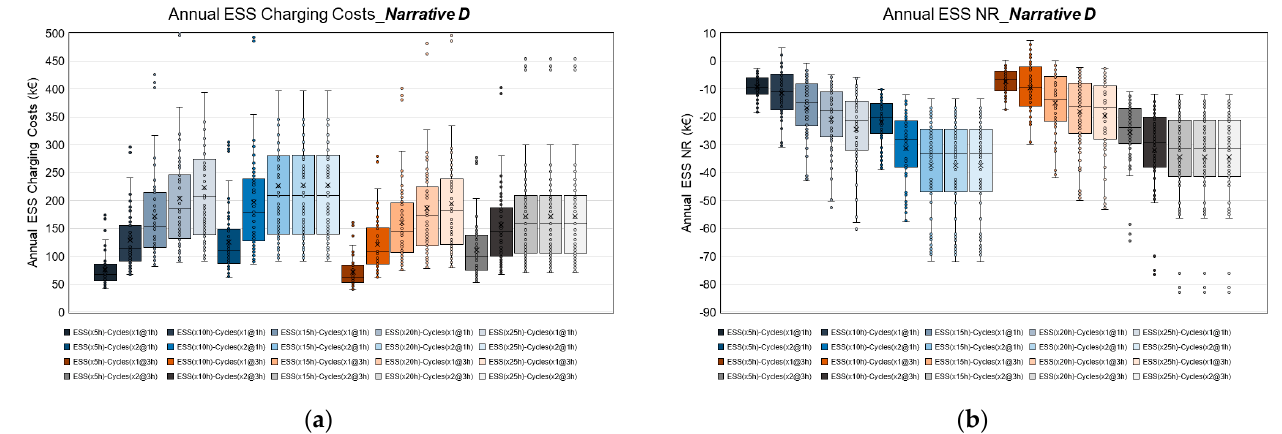
Figure 11. Wind-supported ESS and direct (excess) wind market participation for independent wind and storage actors; annual charging costs ( a ) and NR ( b ) of the storage component per different storage configuration and cycling option.